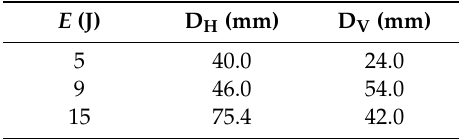
Table 2. Values of D H and D V for the PPB specimen through LT testing.